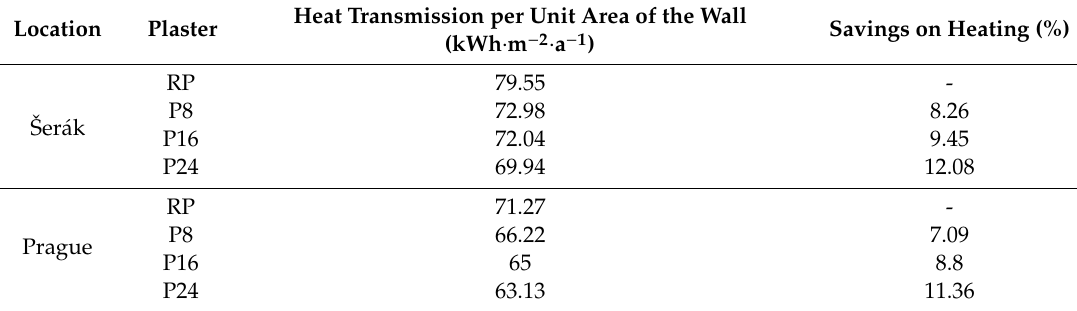
Table 4. Annual heat energy savings produced by FSPCM plaster.